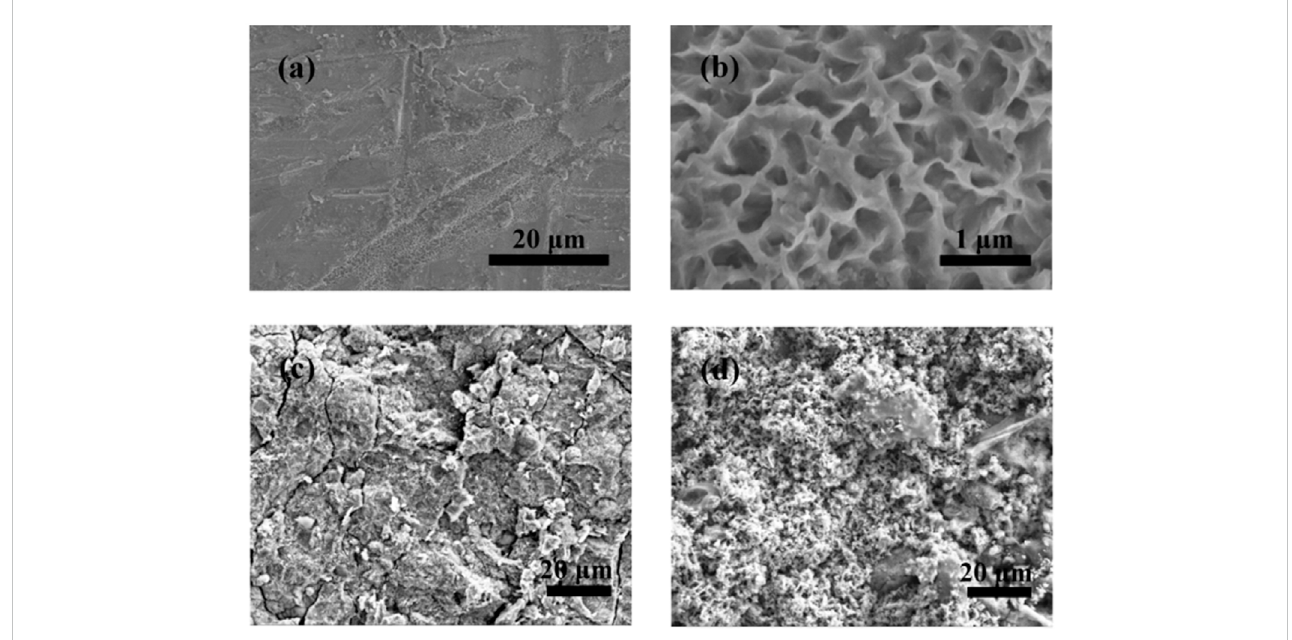
FIGURE 8 Structural characterization of the Zn anodes after galvanostatic discharge and cycling, respectively. (A) Low-magni fi cation and (B) high-magni fi cation SEM images of the Zn anodes after galvanostatic discharge. SEM images of Zn anodes after cycling at (C) 4% DOD and (D) 75% DOD.